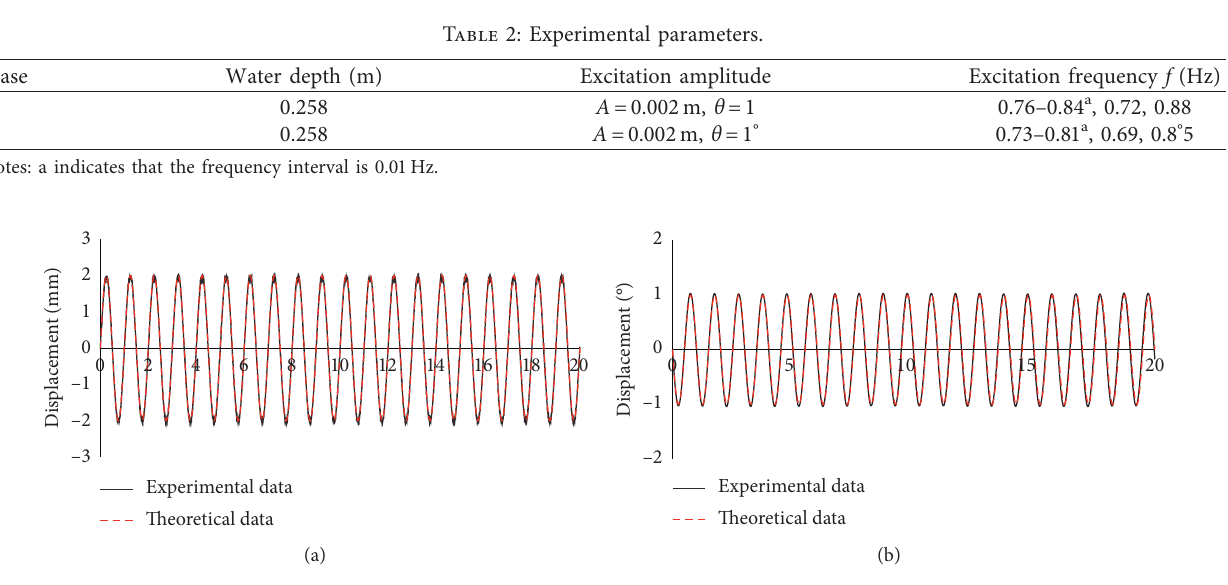
Figure 3: Displacement comparisons between the experimental measurement data and theoretical data: (a) surge excitation with � 1 ° , ( f ) � 1Hz. A � 0.002m, ( f ) � 1Hz; (b) pitch excitation θ 0